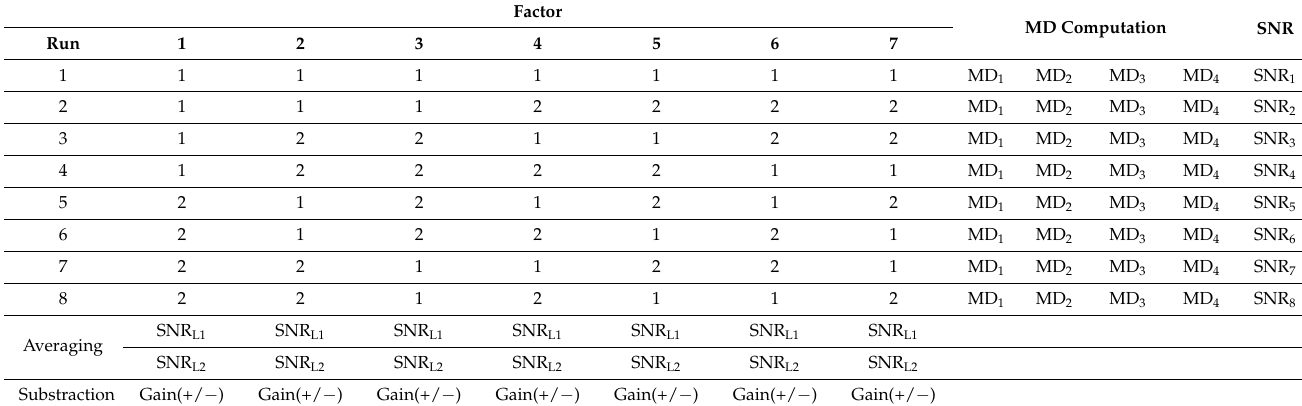
Table 3. An example of useful feature selection using OA ( L 8 2 7 ) and signal-to-noise ratio (SNR).